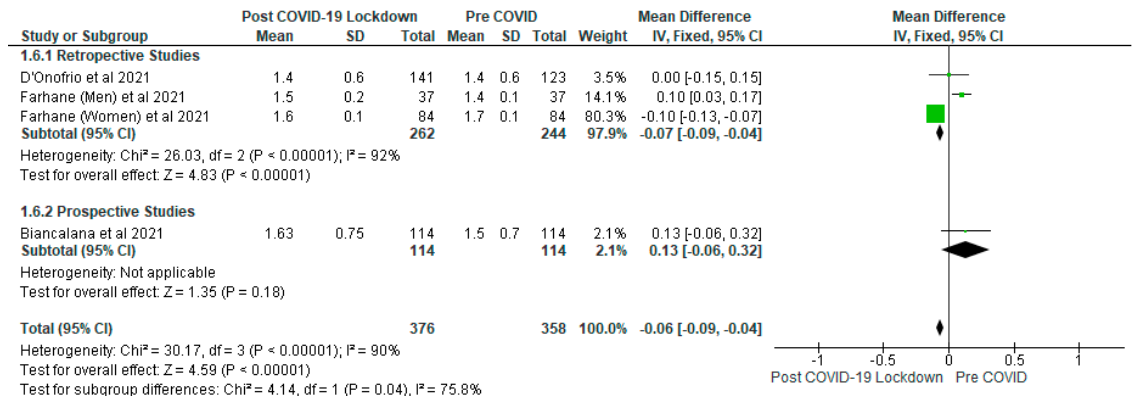
Figure 6. The effect of COVID-19 lockdown on Total Cholesterol (mmol/L). With respect to triglyceride (mmol/L), the mean difference between the post-COVID-19 lockdown gp and pre-COVID gp was − 0.06 (95% CI: − 0.09, − 0.04), involving 3 studies and 734 participants (post-COVID-19 lockdown gp, n = 376; pre-COVID, n = 358) (Figure 7).